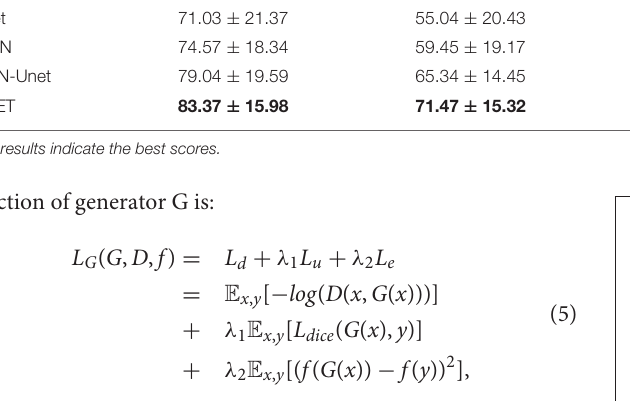
TABLE 2 | Quantitative assessment of U-net (Ronneberger et al., 2015), ACNN (Oktay et al., 2017), cGAN-Unet (Singh et al., 2018), and the FSPET model. Model